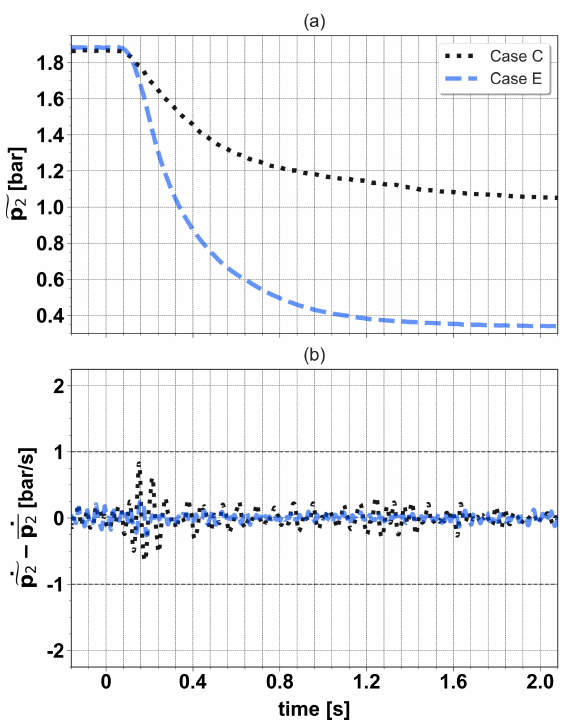
Figure A1. Time evolution of compressor outlet pressure ( a ) and its time derivative ( b ) for Case C and Case E.